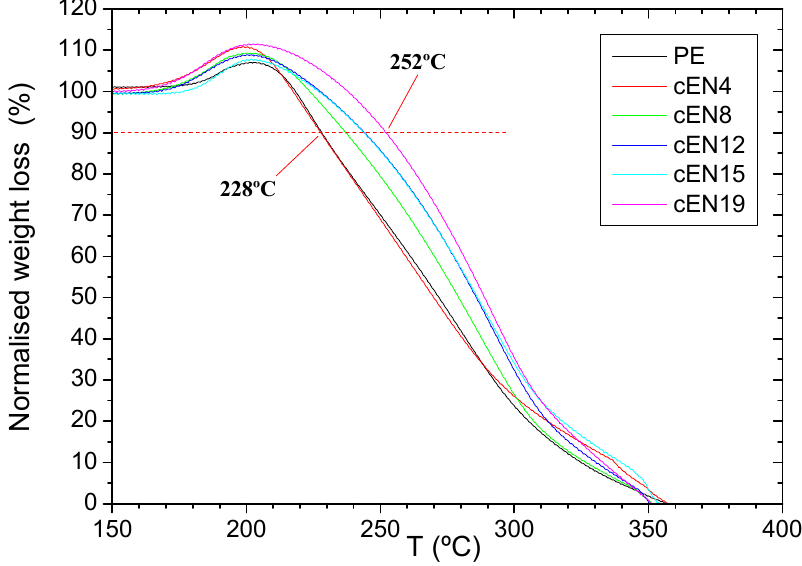
Figure 6. Normalized weight loss for the samples under oxidation conditions.